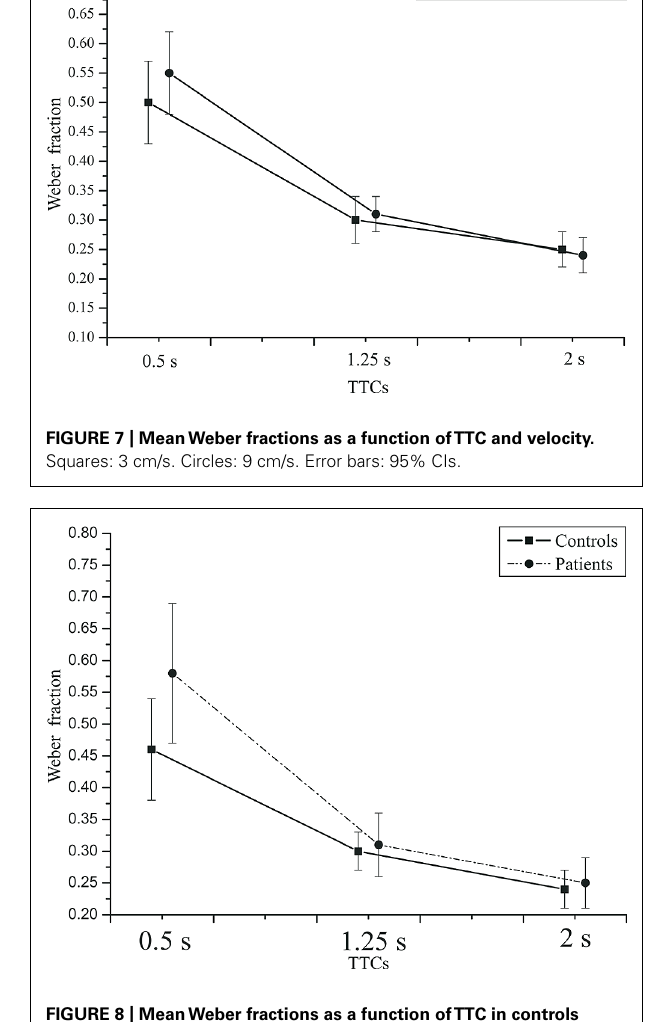
participants’ subjective flow of time on the day of the experimen- tation. The time estimates depended on the task and the interval duration, but not on the depression status (patients vs.